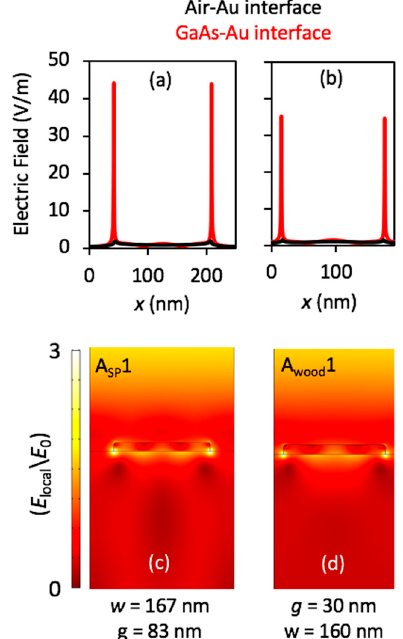
Figure 6. ( a ) and ( c ) A sp 1 and ( b ) and ( d ) A wood 1 peaks as shown in Figure 3. ( a ,b) Electric field distributions on the top and the bottom interfaces of the nanostructure; and ( c , d ) over the entire model space. ( a ) and ( c ) are when P = 250 nm ( w = 167 nm and g = 83 nm), and ( b ) and ( d ) when P = 190 nm ( w = 160 nm and g = 30 nm).